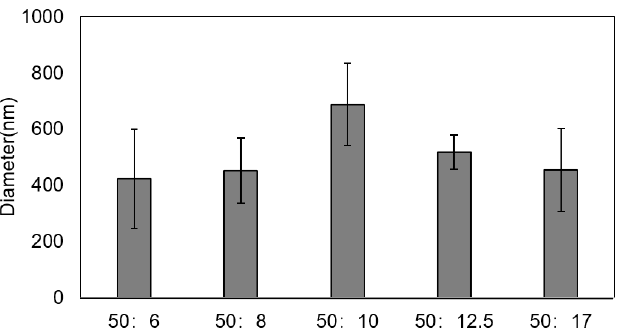
Figure 2. Size distributions of chitosan particles with different ratios ( w/v ) of chitosan/sodium tripolyphosphate solution .